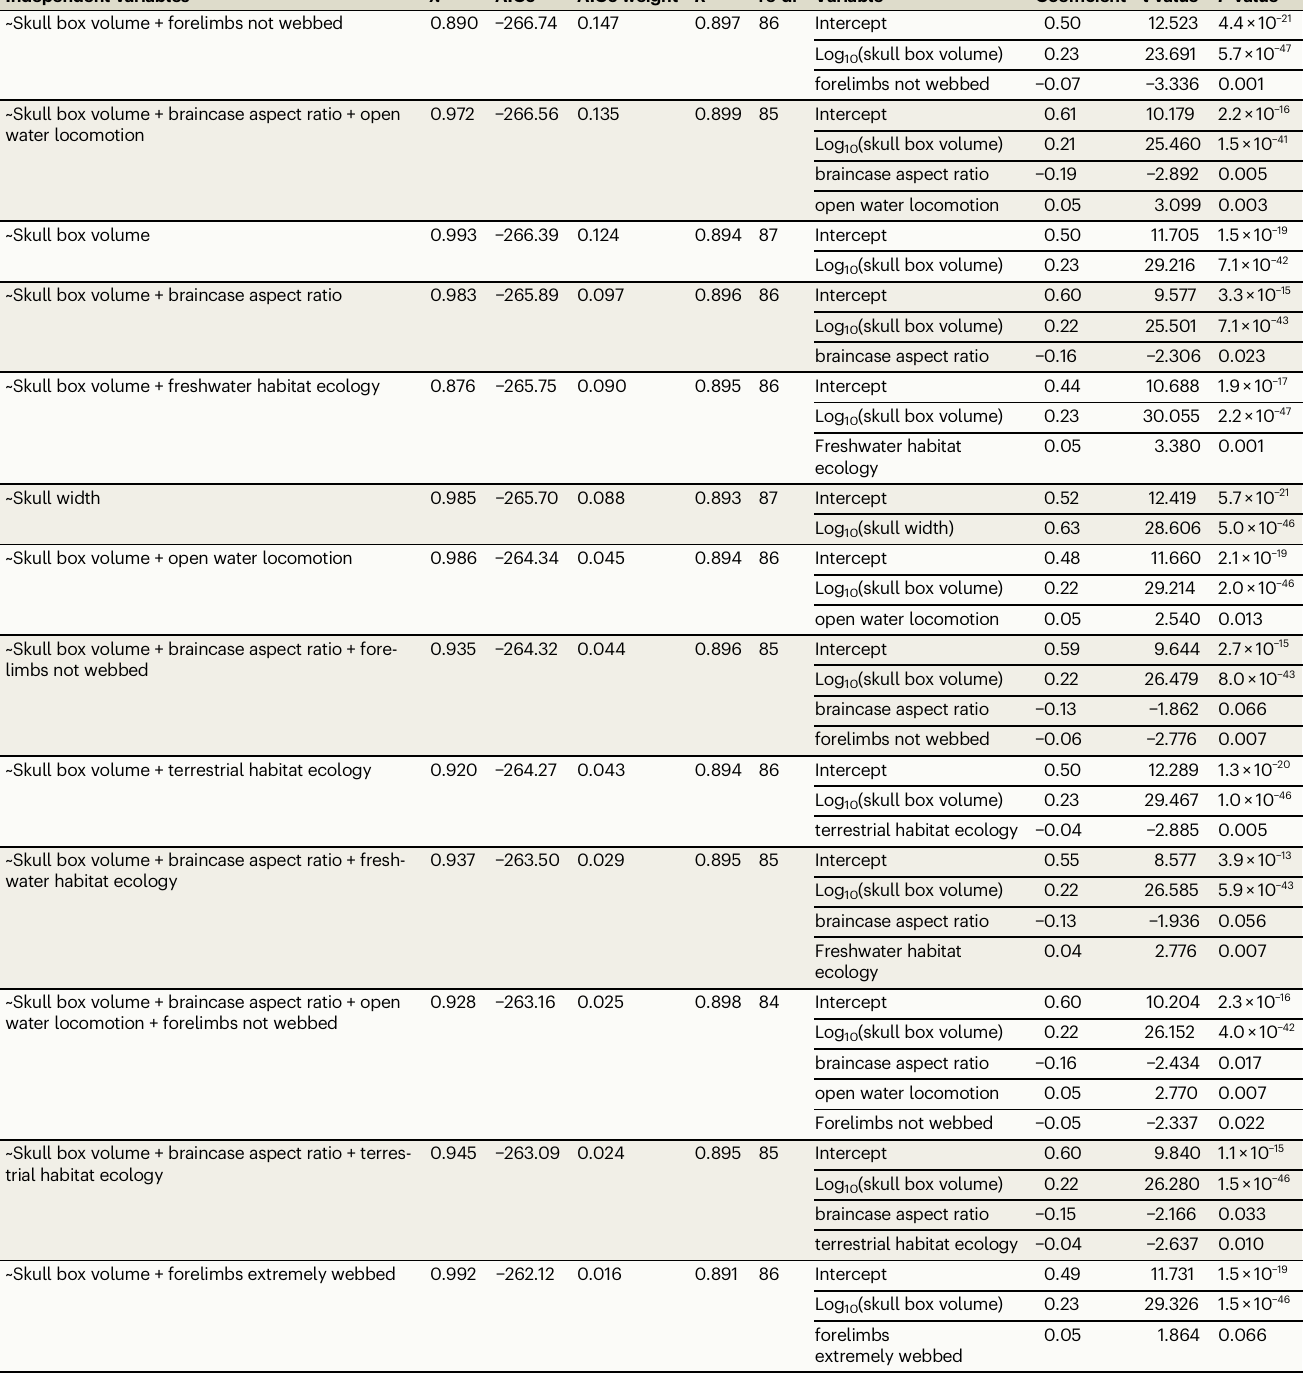
Table 2 | Results of pGLS regressions of labyrinth centroid size ~ independent variables for extant turtles, showing only models with non-negligible AICc values (full table in Supplementary Data 14) Independent